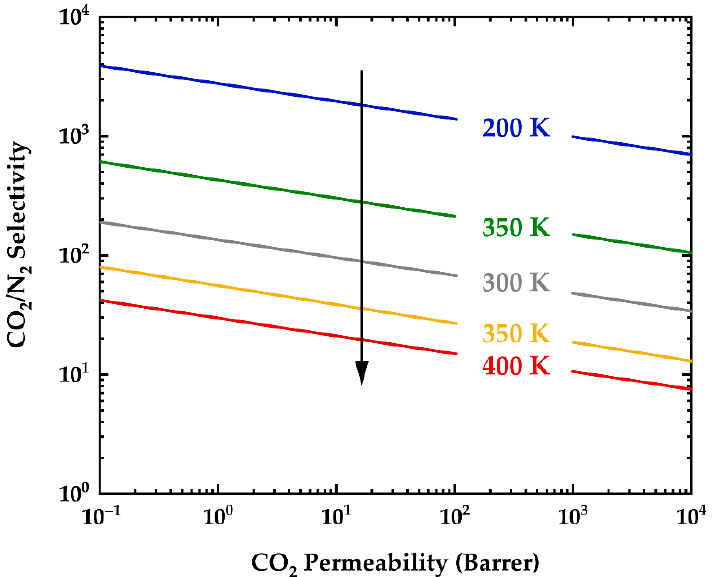
Figure 6. Influence of temperature on the upper bound selectivity for CO 2 /N 2 separations. Copyright 2010. Reproduced from [138] with permission from Elsevier Ltd.